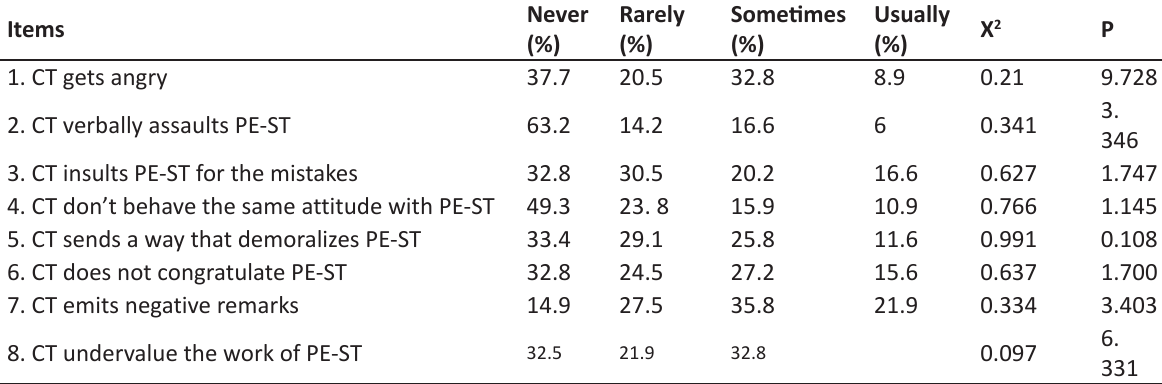
Table 2: The different items of the CT behavior Items